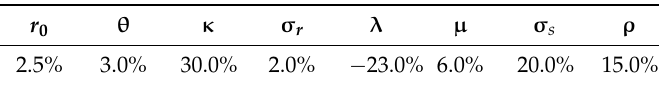
Table 2. Capital market parameters.